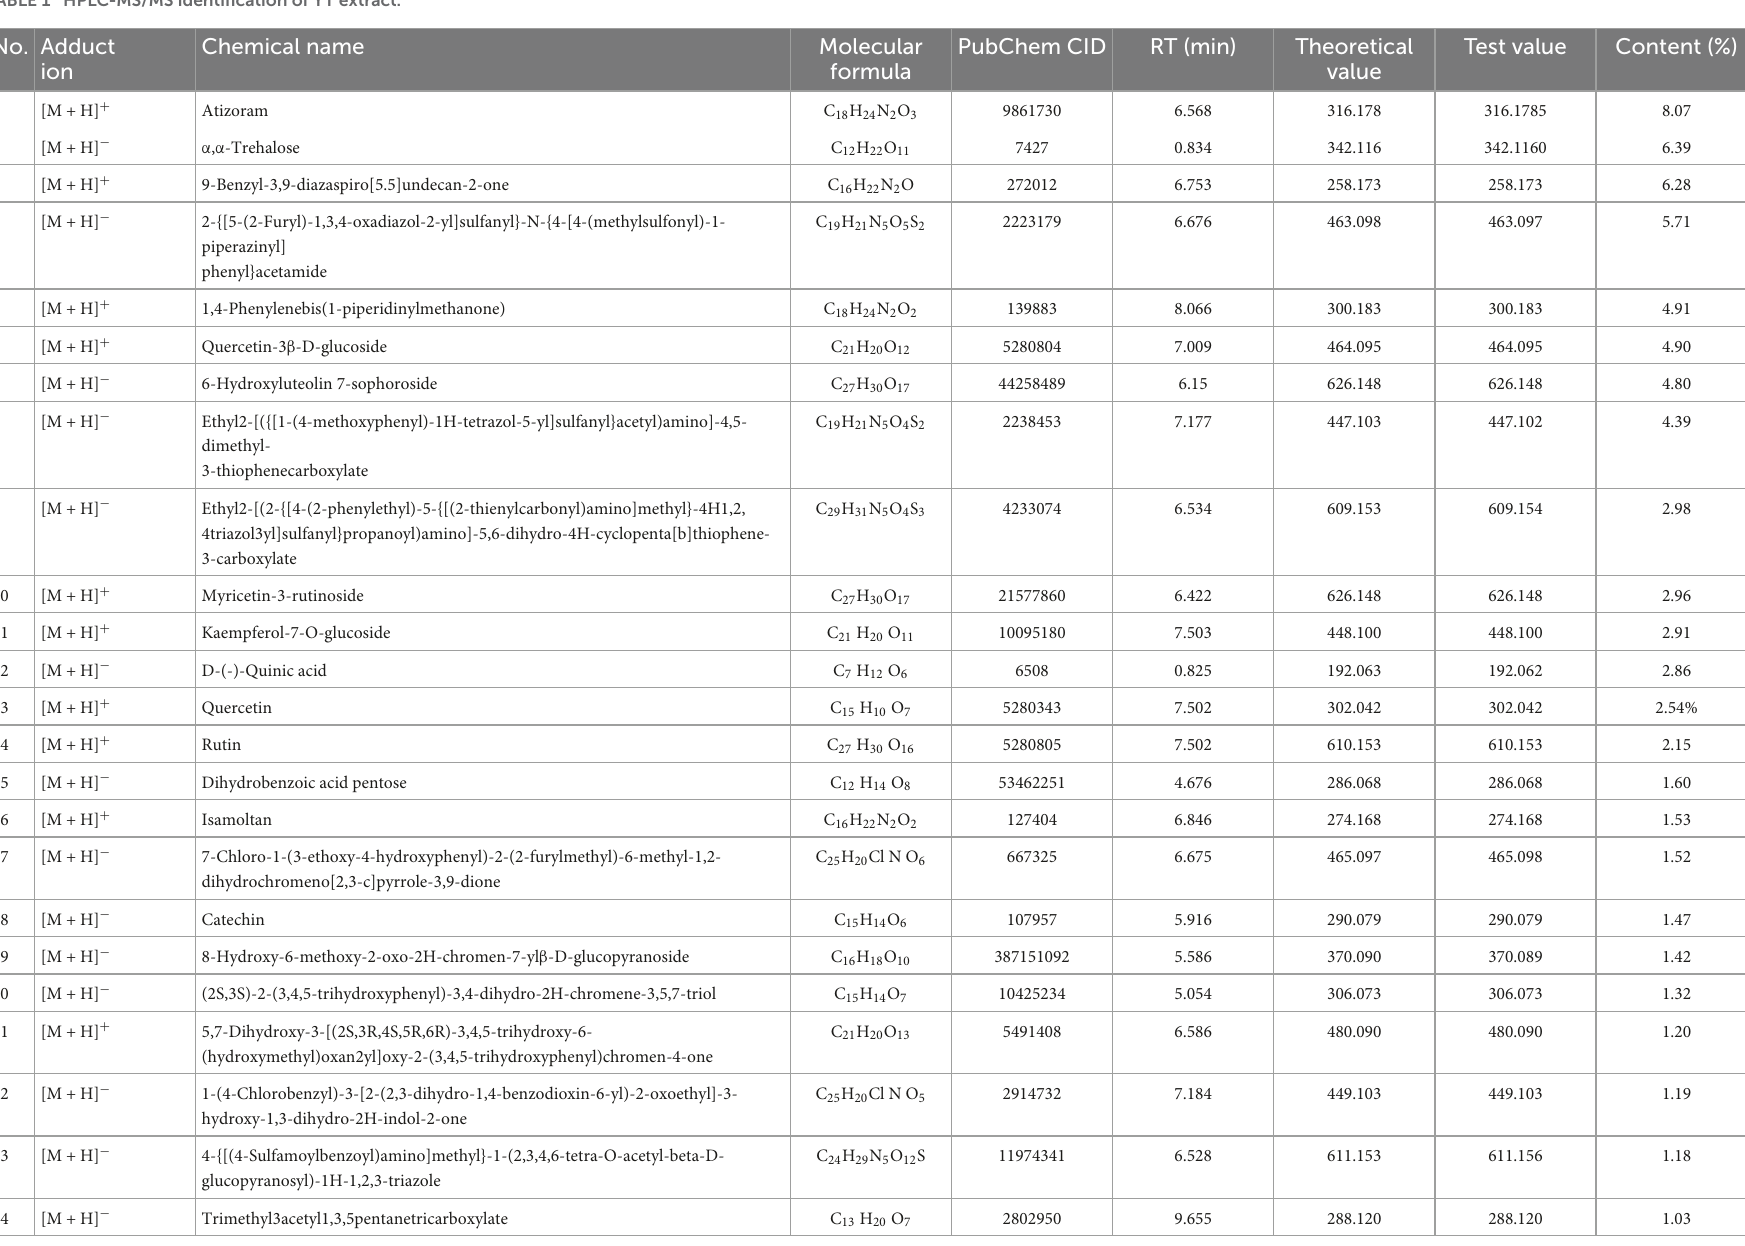
TABLE 1 HPLC-MS/MS identification of YT